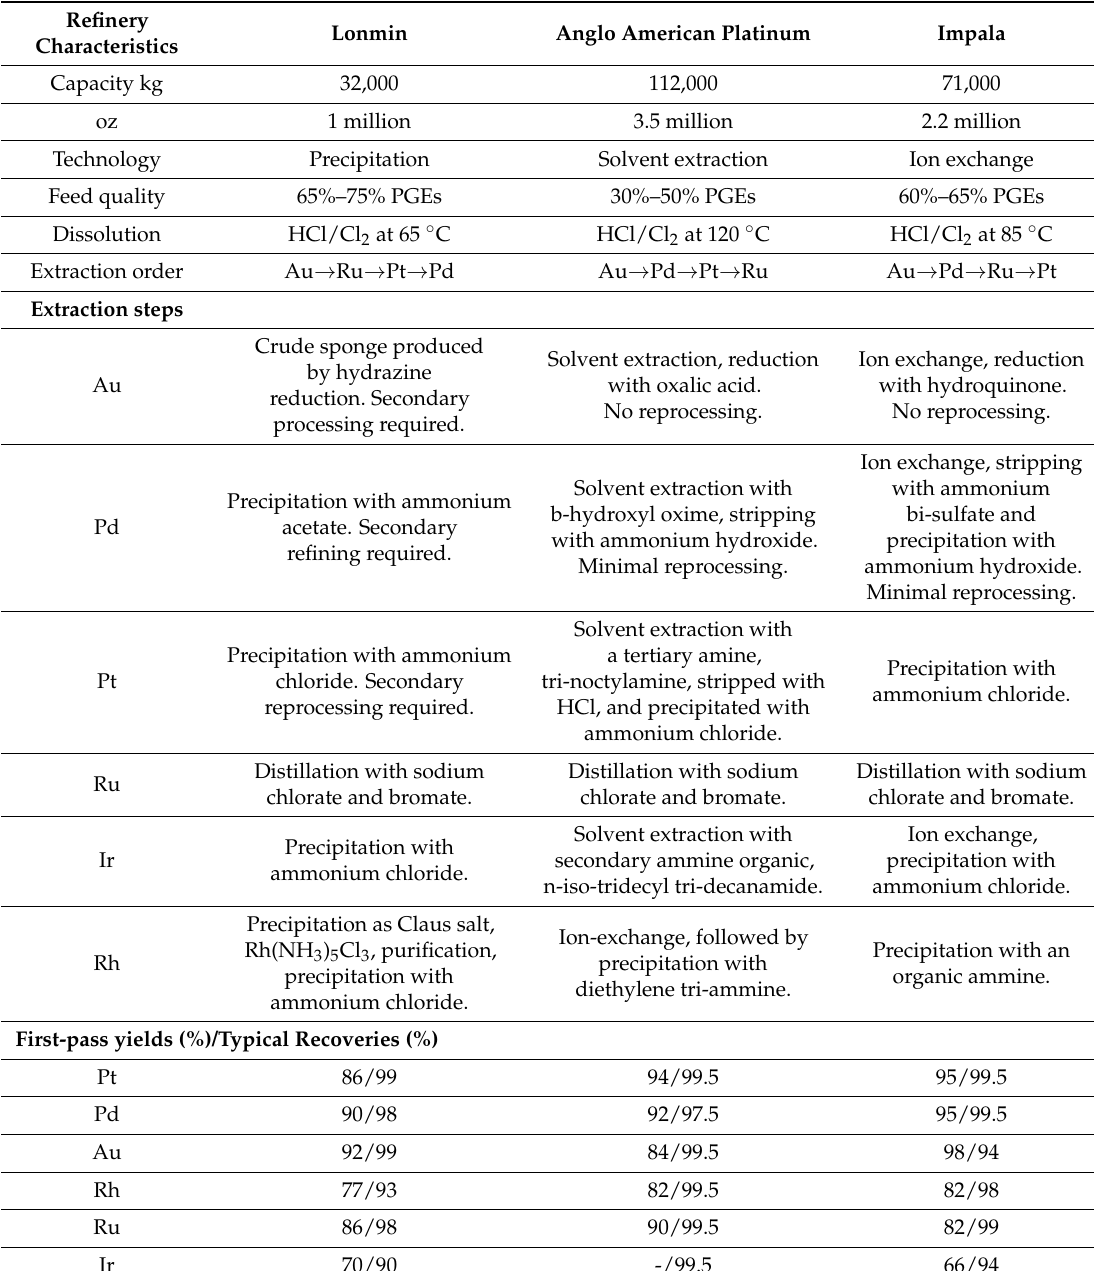
Table 3. Methods of PGE extraction in selected refineries